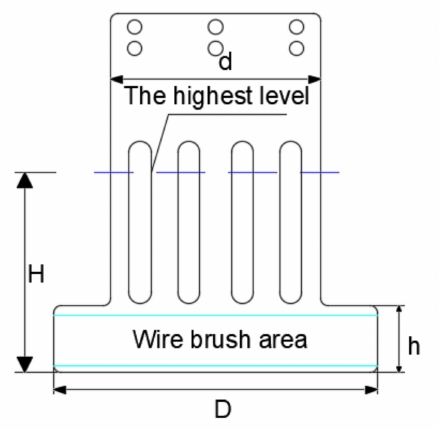
Figure 2. C-brush plate.